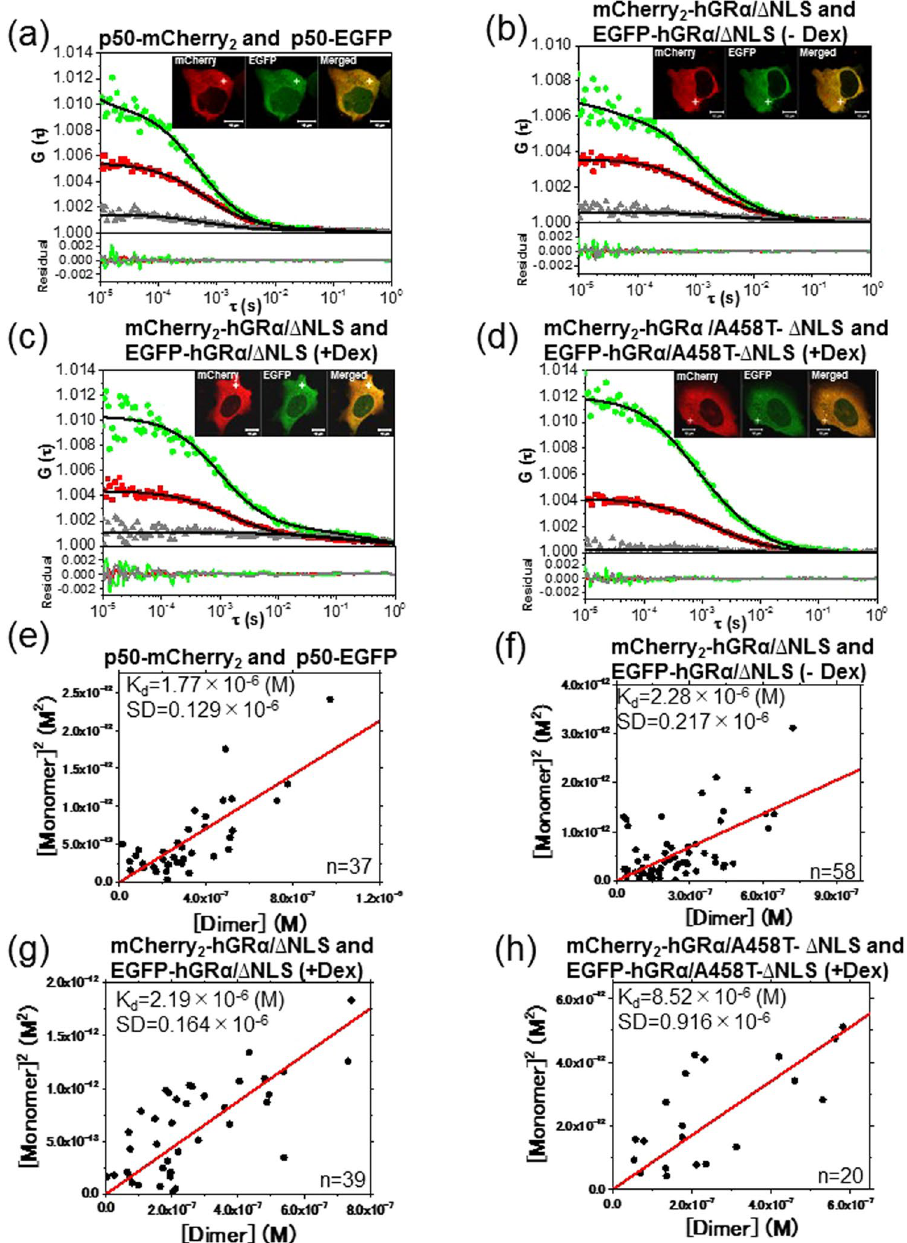
Figure 6. The effect of NLS mutation on formation of the GR α dimer. Typical auto- and cross-correlation curves obtained from U2OS cells coexpressing the pairs of chimeric fusion proteins before and after addition of the ligand. The filled green diamonds, red squares, and gray triangles denote autocorrelation of the green channel [ G G ( τ )], autocorrelation of the red channel [ G R ( τ )], and the cross-correlation curve [ G C ( τ )], respectively, with their fits (solid black lines) and residuals. The insets show LSM images of the U2OS cells coexpressing the pairs of chimeric fusion proteins. FCCS analyses were carried out in the cytoplasm, which is indicated by the white crosshairs. The scale bars are 10 μ m. FCCS was performed using U2OS cells coexpressing ( a ) p50-mCherry 2 and p50-EGFP as a positive control, ( b ) mCherry 2 -hGR α / ∆ NLS and EGFP-hGR α / ∆ NLS before addition of Dex, ( c ) mCherry 2 -hGR α / ∆ NLS and EGFP-hGR α / ∆ NLS 20 min after addition of 100 nM Dex, or ( d ) mCherry 2 -hGR α / A458T - ∆ NLS and EGFP-hGR α / A458T - ∆ NLS 20 min after addition of 100 nM Dex. ( e–h ) Results of K d determination using scatter plots and linear regression. The plots represent the square of the concentration of the monomeric hGR α versus the concentrations of hGR α dimer. The solid line shows the linear fit. The slope indicates the K d . ( e ) p50 - mCherry 2 and p50-EGFP. ( f ) mCherry 2 -hGR α / ∆ NLS and EGFP-hGR α / ∆ NLS before addition of Dex. ( g ) mCherry 2 -hGR α / ∆ NLS and EGFP-hGR α / ∆ NLS after addition of Dex. ( h ) mCherry 2 -hGR α /A458T- ∆ NLS and EGFP-hGR α /A458T- ∆ NLS after addition of